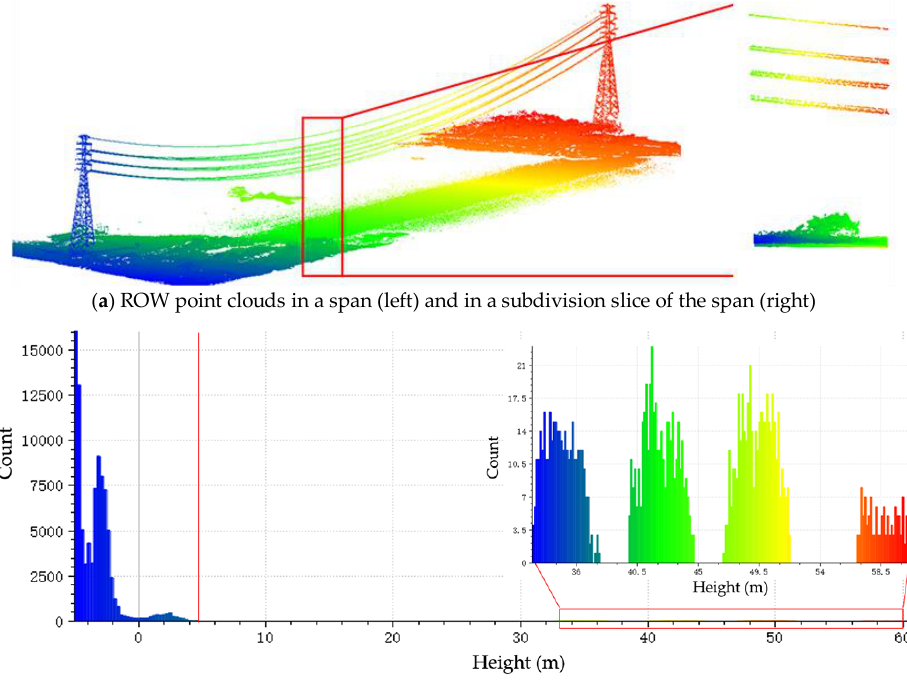
Figure 2. Subdivision slice based geometric distribution analysis of the point clouds in a span.